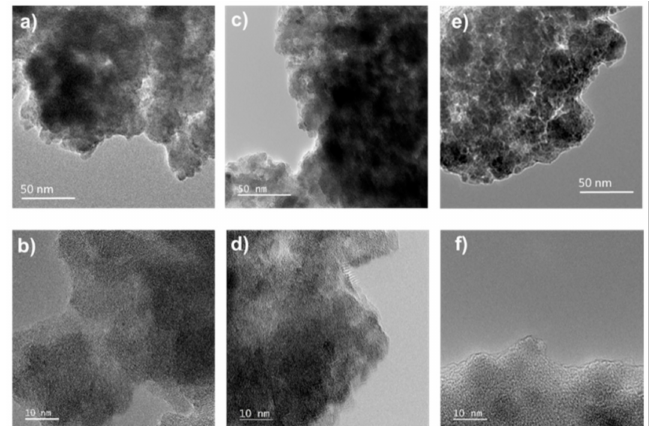
Figure 6. TEM images of raw FWO-600 particles ( a , b ), after 10,000 cycles ( c , d ) and from the blank electrode soaked in the electrolyte ( e , f ). Scale bar for figures a, c and e is 50 nm while it is 10 nm for figures ( b , d , f